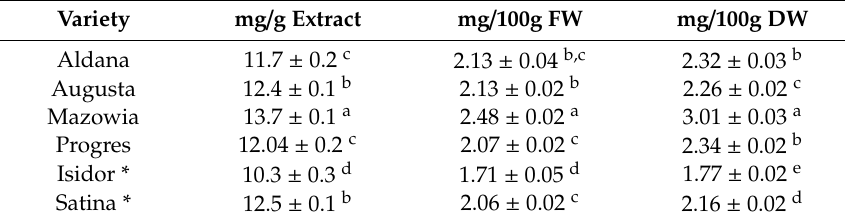
Table 1. The total phenolics contents (TPCs) in soybean seeds. Variety